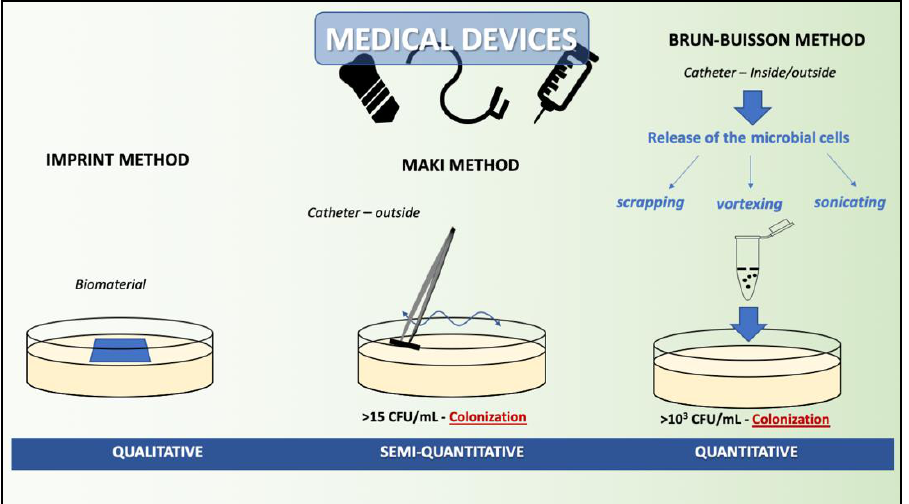
Figure 4. of biofilm examination from medical devices. Figure 4. Methods of biofilm examination from medical